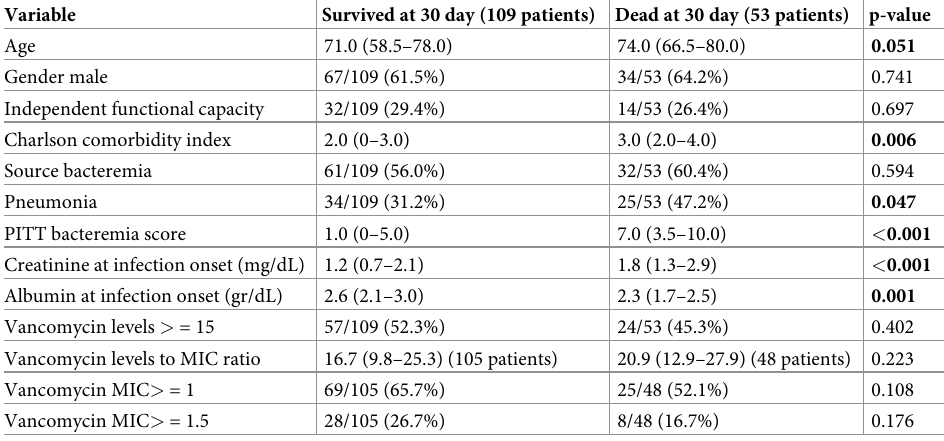
Table 3. Univariate analysis of risk factors for mortality among 162 propensity score-matched patients.